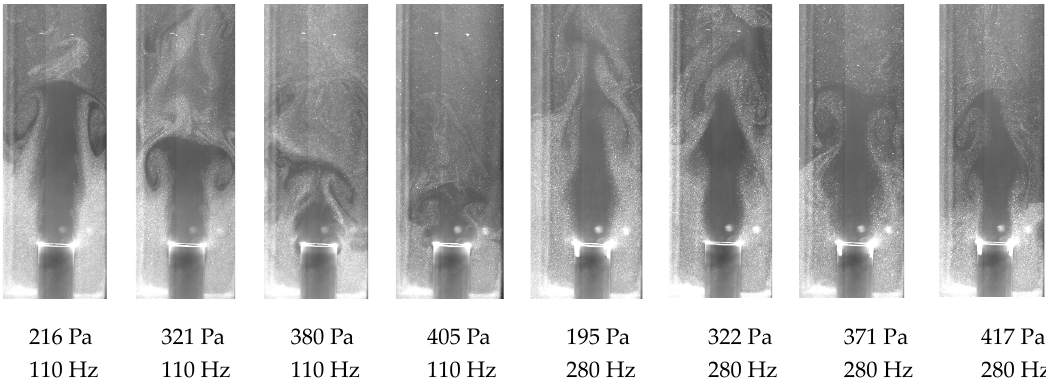
Figure 10. Mie scattering images at different acoustic parameters.